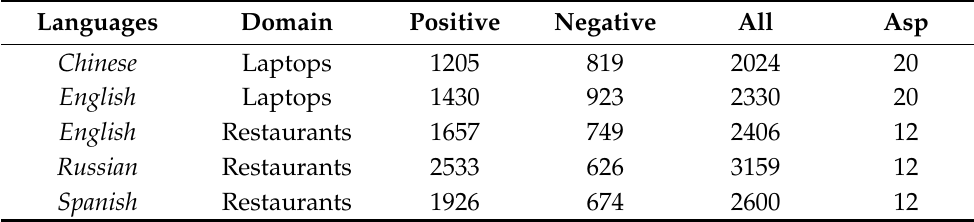
Table 1. Corpus statistics. Note that Asp denotes the number of the aspect